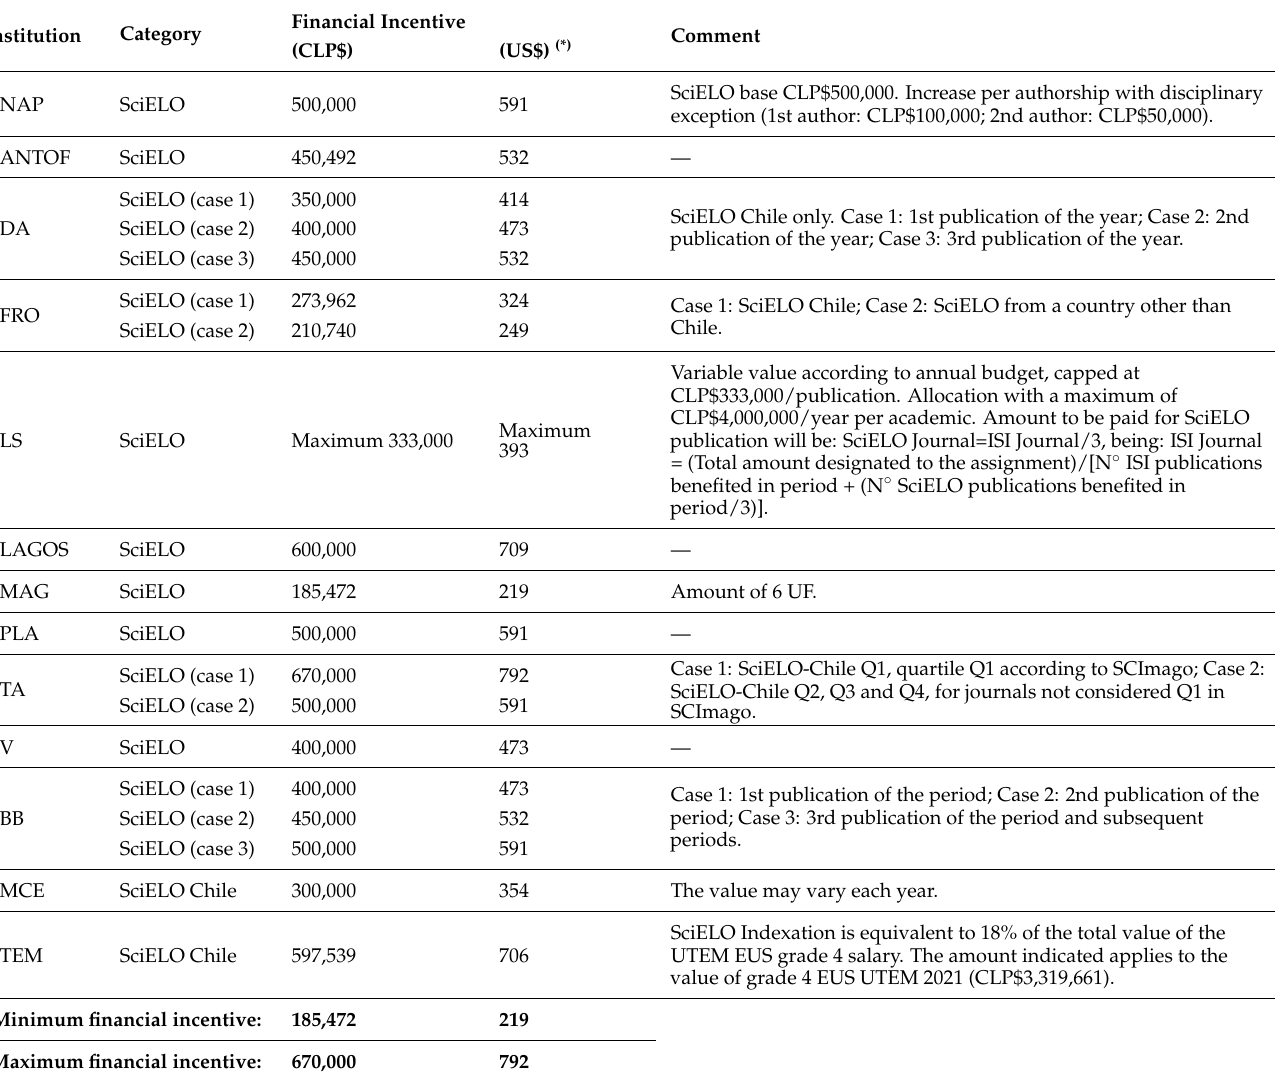
Table 6. Incentive amounts for publications indexed in